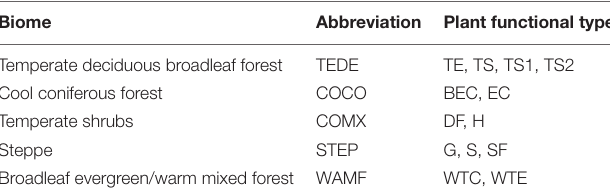
TABLE 3 | Assignment of plant functional types (PFTs) at Daye Lake to